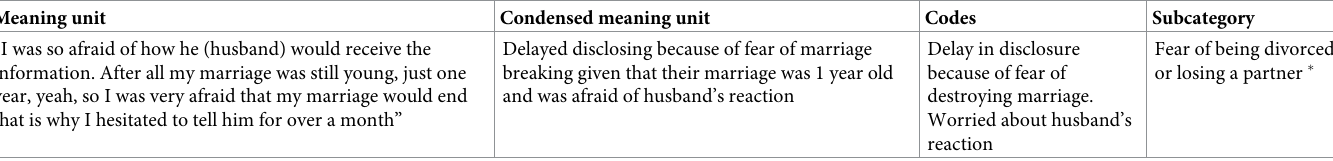
Table 1. Example of the analysis